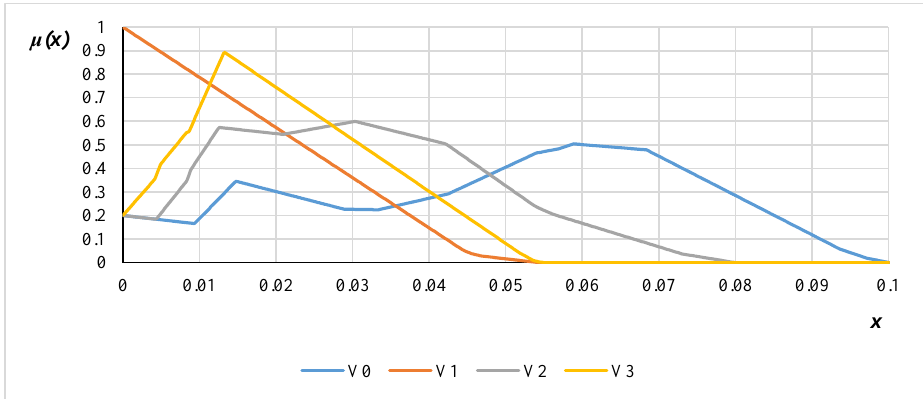
Figure 15. Total susceptibility c of alternatives when analysing positive relationships.